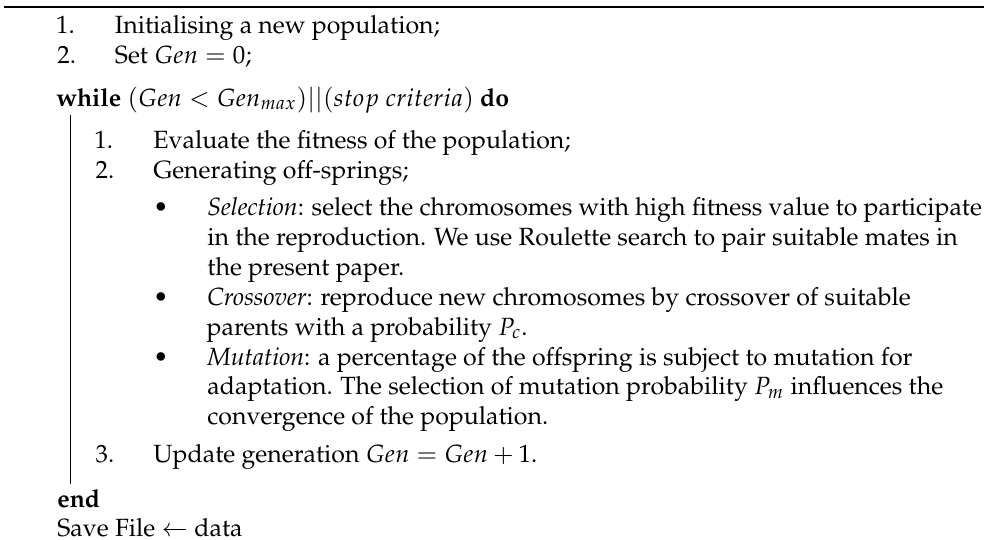
Algorithm 1: Genetic algorithm